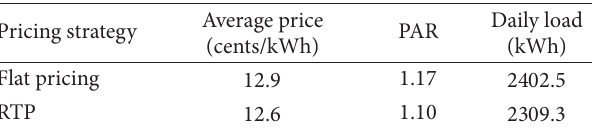
Table 1: Comparison of the scheduling strategies with RTP and flat pricing.